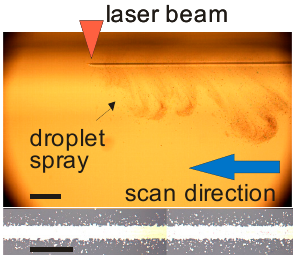
Figure 3. Image of the spray ejection during CW-LIFT of a silver nanoparticle ink at a laser power density of 13 kW / cm 2 and a scan speed of 300 mm / s. The donor film is in the top of the picture. The laser impinged from above, scanning from right to left. The laser spot position when the picture was taken is indicated with red arrow. Below, an image of a conductive line printed under the same conditions with the receiving substrate placed at 150 µ m. Scale bars are 500 µ m in both pictures. Readapted from